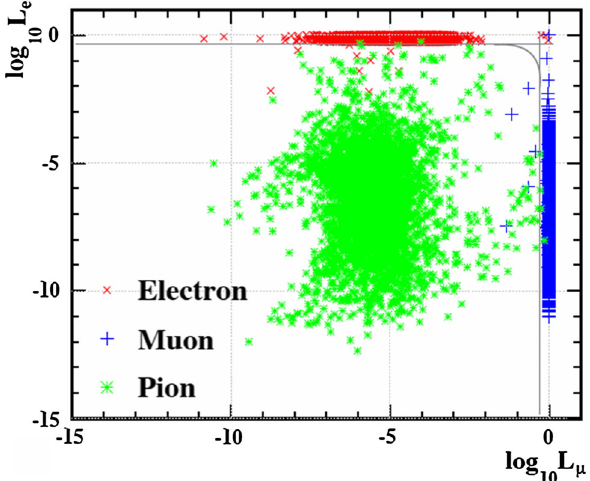
Fig. 4 The e-likeliness and μ -likeness of e − , μ − and π + at 40 GeV, grey lines are the cuts for different catalogs in next section Table 2 Migration matrix at 40 GeV (%) Type